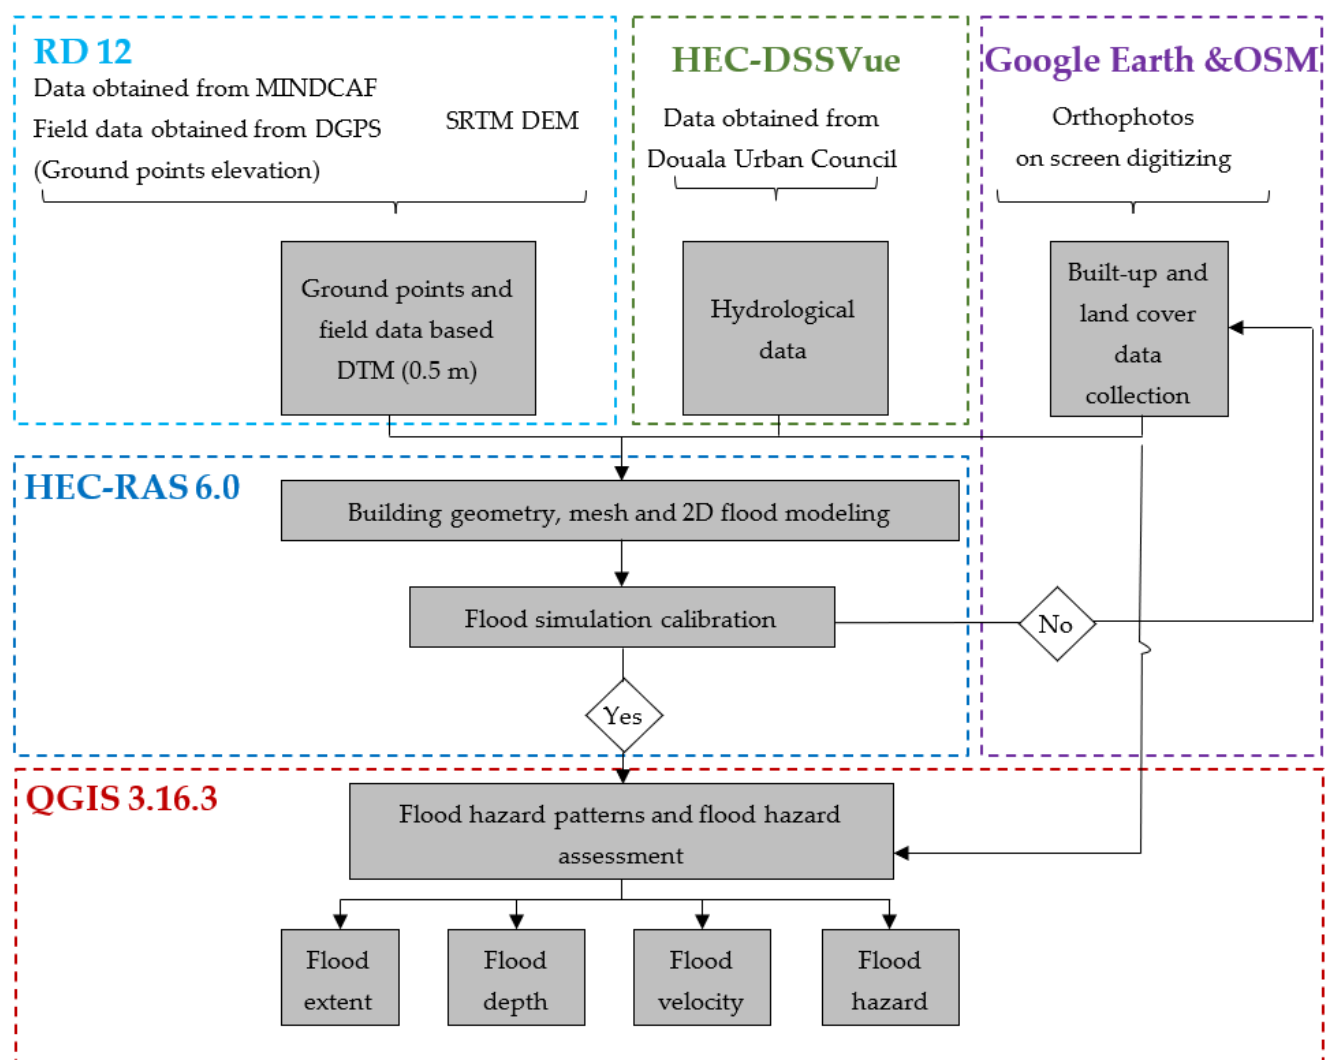
Figure 3. Overall methodology of the study.